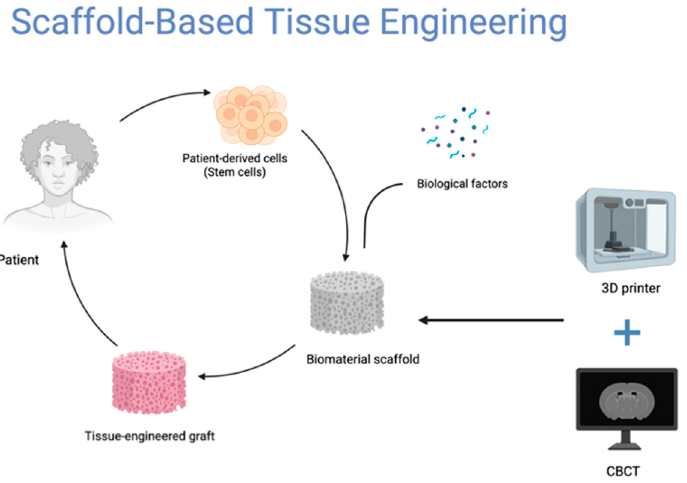
Figure 1. Schematic illustration of the incorporation of CBCT scanning and 3D printing in the workflow of scaffold-based tissue engineering.